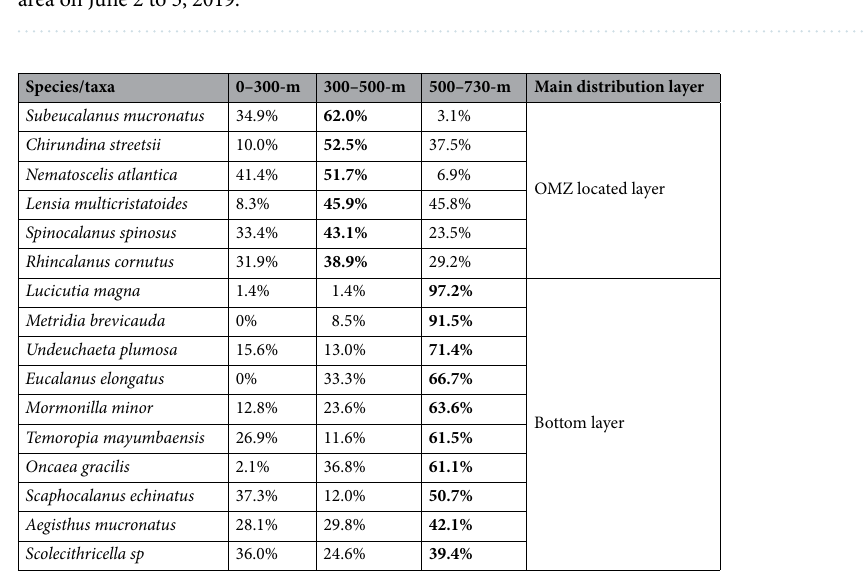
Figure 3. The diel vertical variations of zooplankton abundance and diversity ( H’ ) in the Caroline Seamount area on June 2 to 3, 2019.